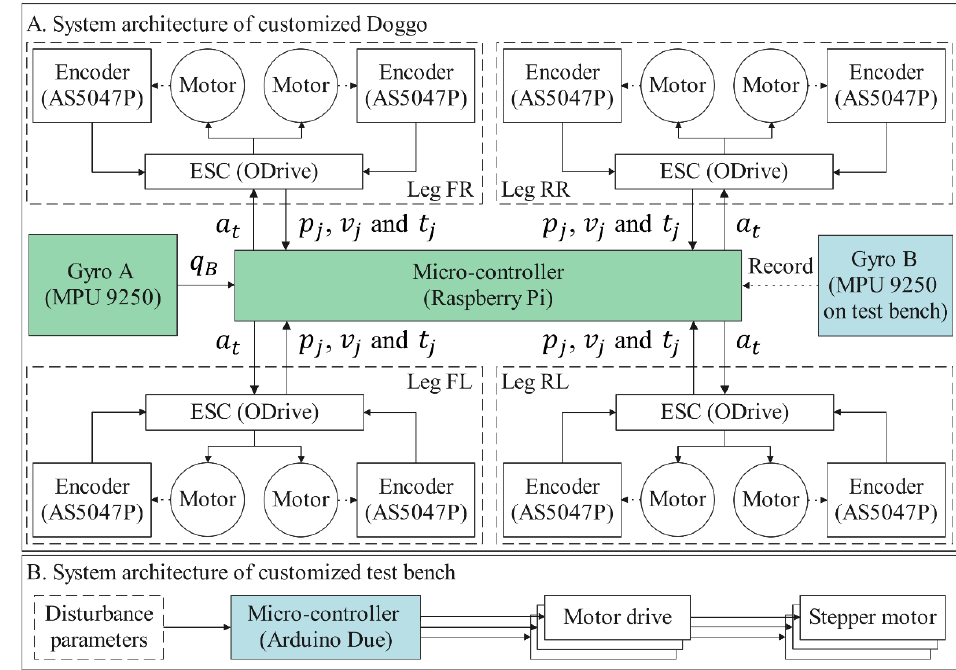
Figure 5. Embedded system architecture of experimental setup.